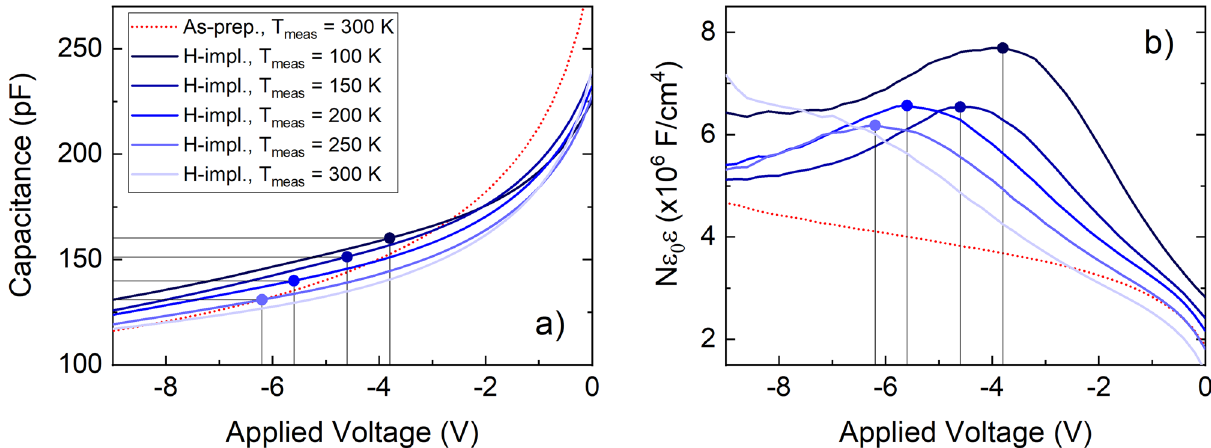
Figure 1. Capacitance (a) of a TiO 2 -N 2 sample (probing frequency 60 kHz) and the N ( V )ε 0 ε product (b) as functions of applied voltage. The red, dotted curve shows the as-prepared sample, i.e., after the N 2 heat treatment but prior to H + implantation. The blue, solid curves are for the H-implanted sample measured at different temperatures ( T meas ). The peaks in N ( V )ε 0 ε are indicated by the drop-down lines. The corresponding capacitance values, obtained at the same applied voltages, are also marked in (a)